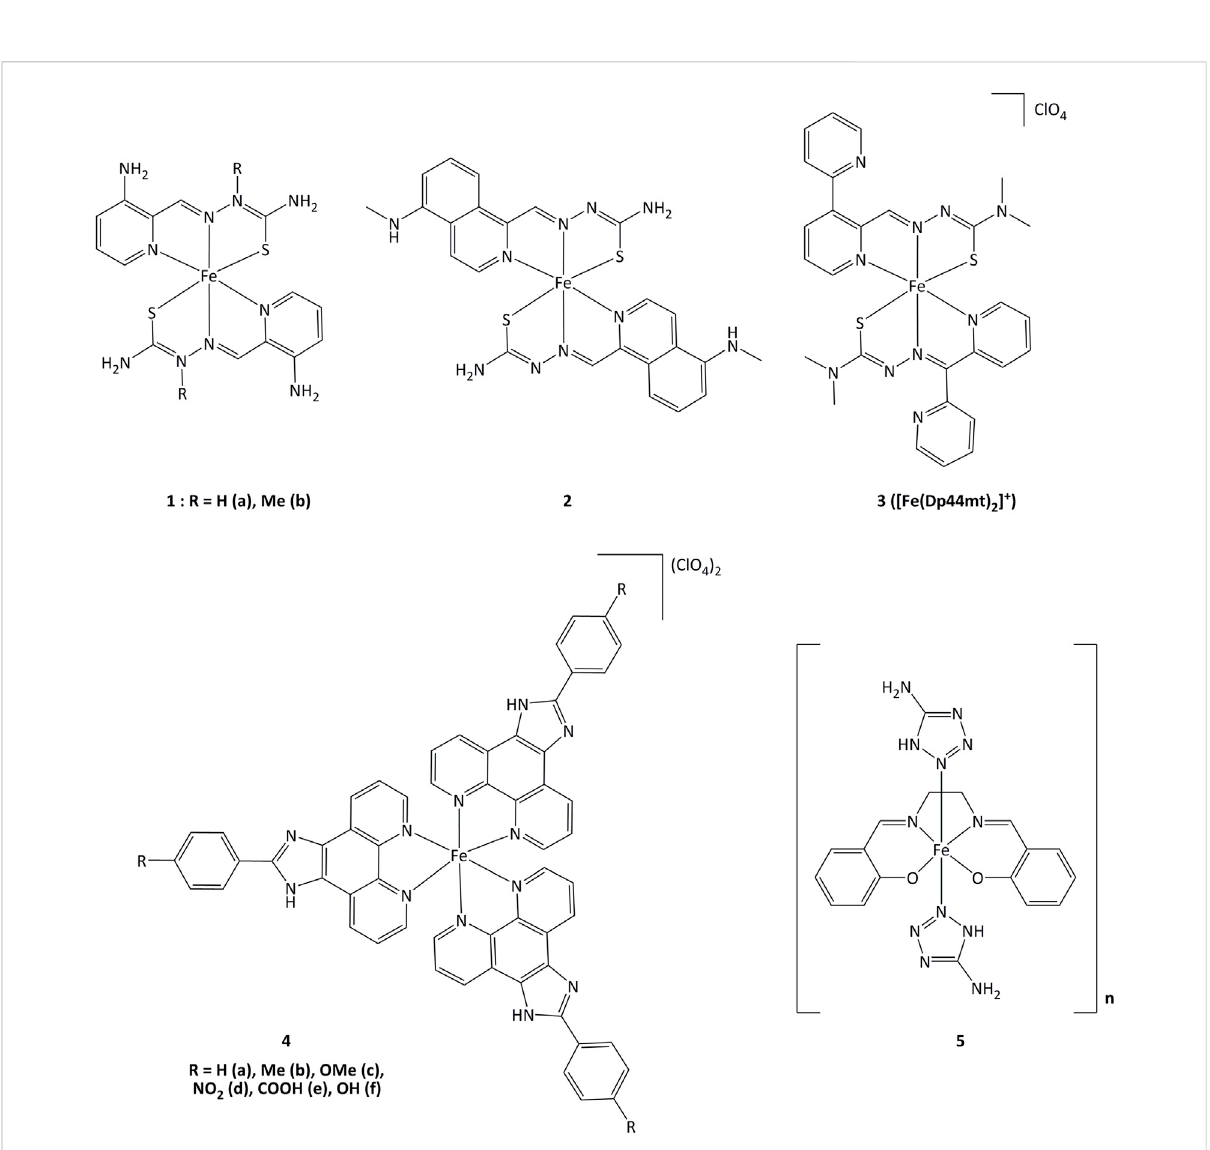
FIGURE 6 Iron complexes able to alter redox enzymatic